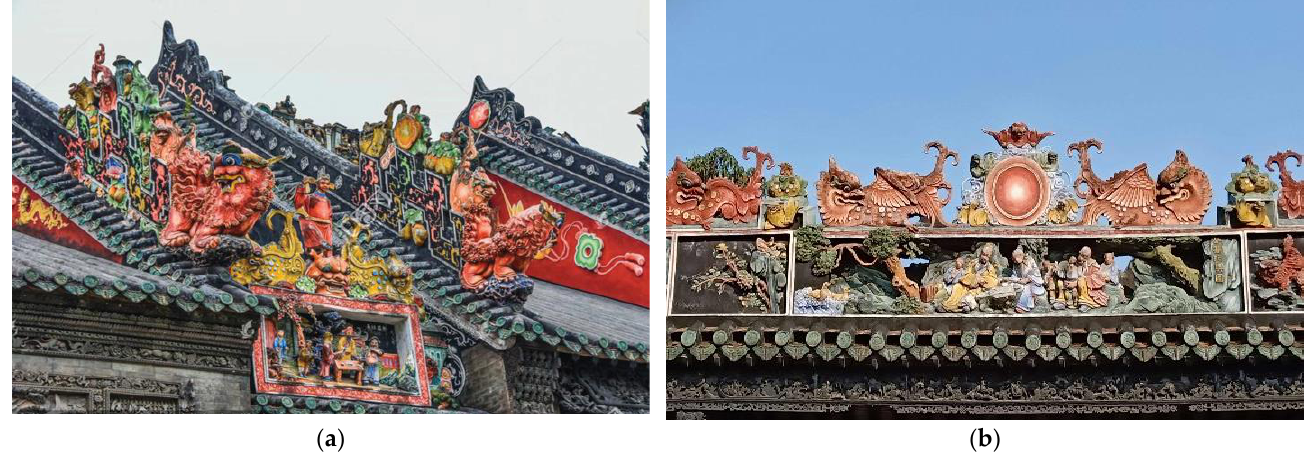
Figure 18. Pottery sculpture ridges at Chen Clan